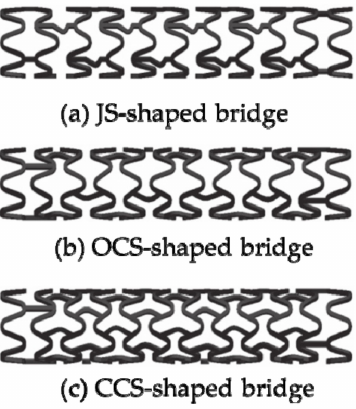
Figure 10. Models of vascular stents [102,103]: ( a ) JS-shaped; ( b ) OCS-shaped; ( c )